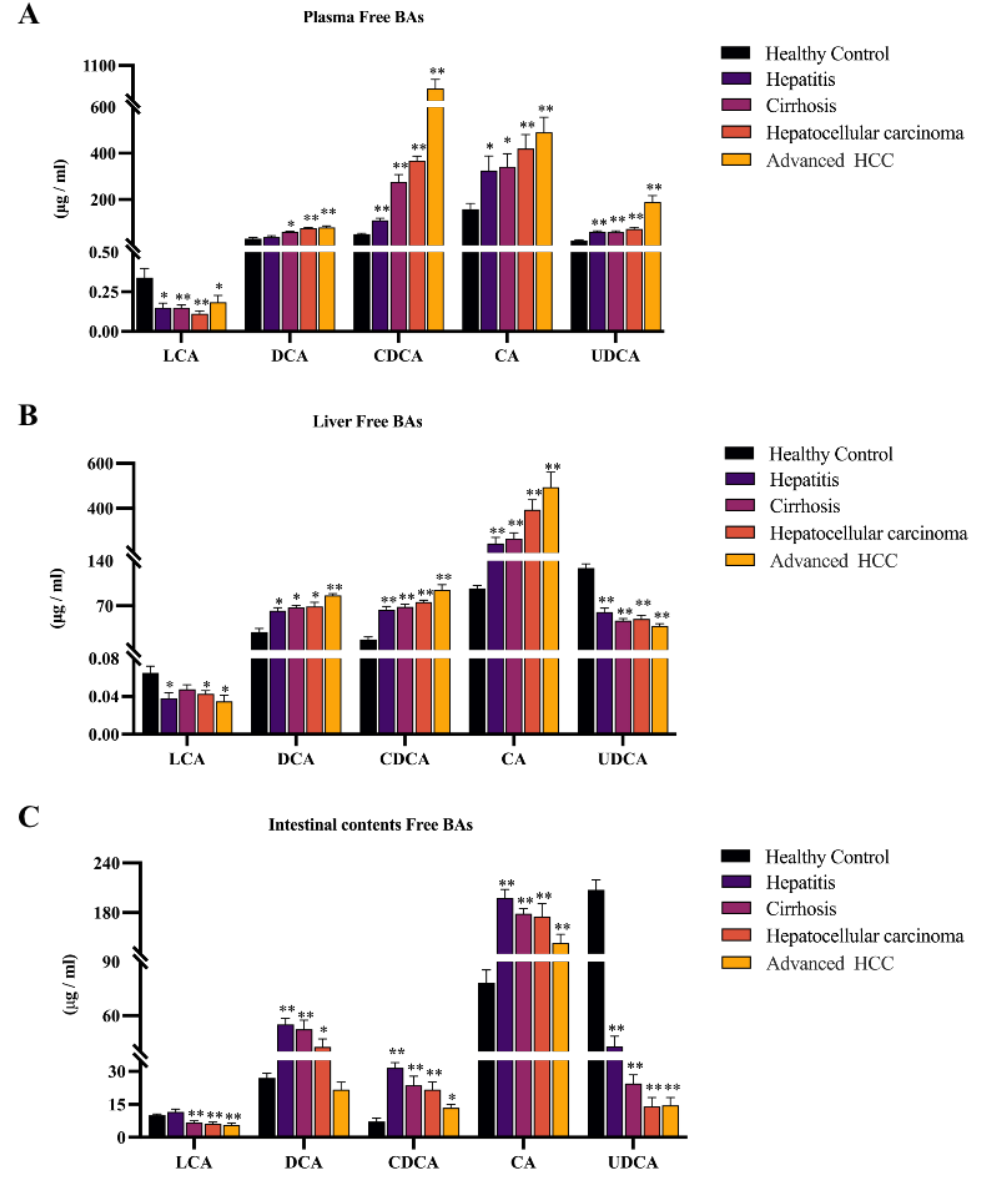
Figure 3. Significant changes in the composition of the free bile acid pool in DEN-induced HCC model rats. Hydrophobic BAs were elevated, and hydrophilic BAs were downregulated in the liver ( B ) and intestinal contents ( C ). In addition, plasma ( A ) was elevated except for LCA. The Figure indicates statistical significance compared with healthy controls by t -tests, * p < 0.05, ** p < 0.01.